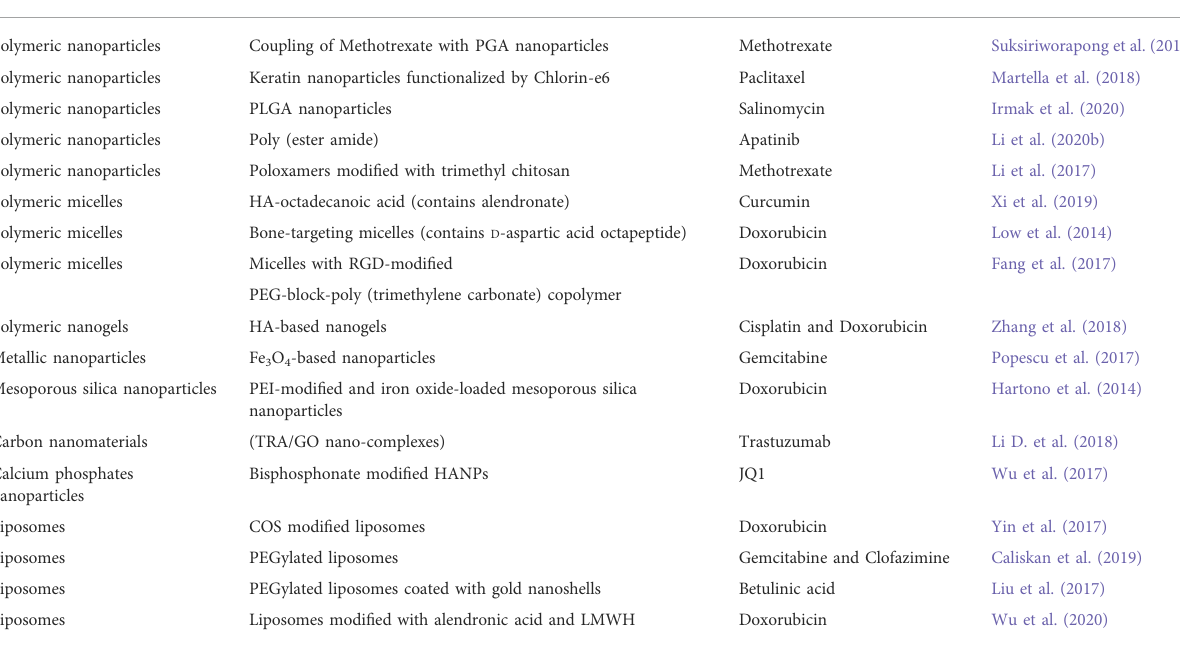
TABLE 2 Drug delivery systems developed for the treatment of